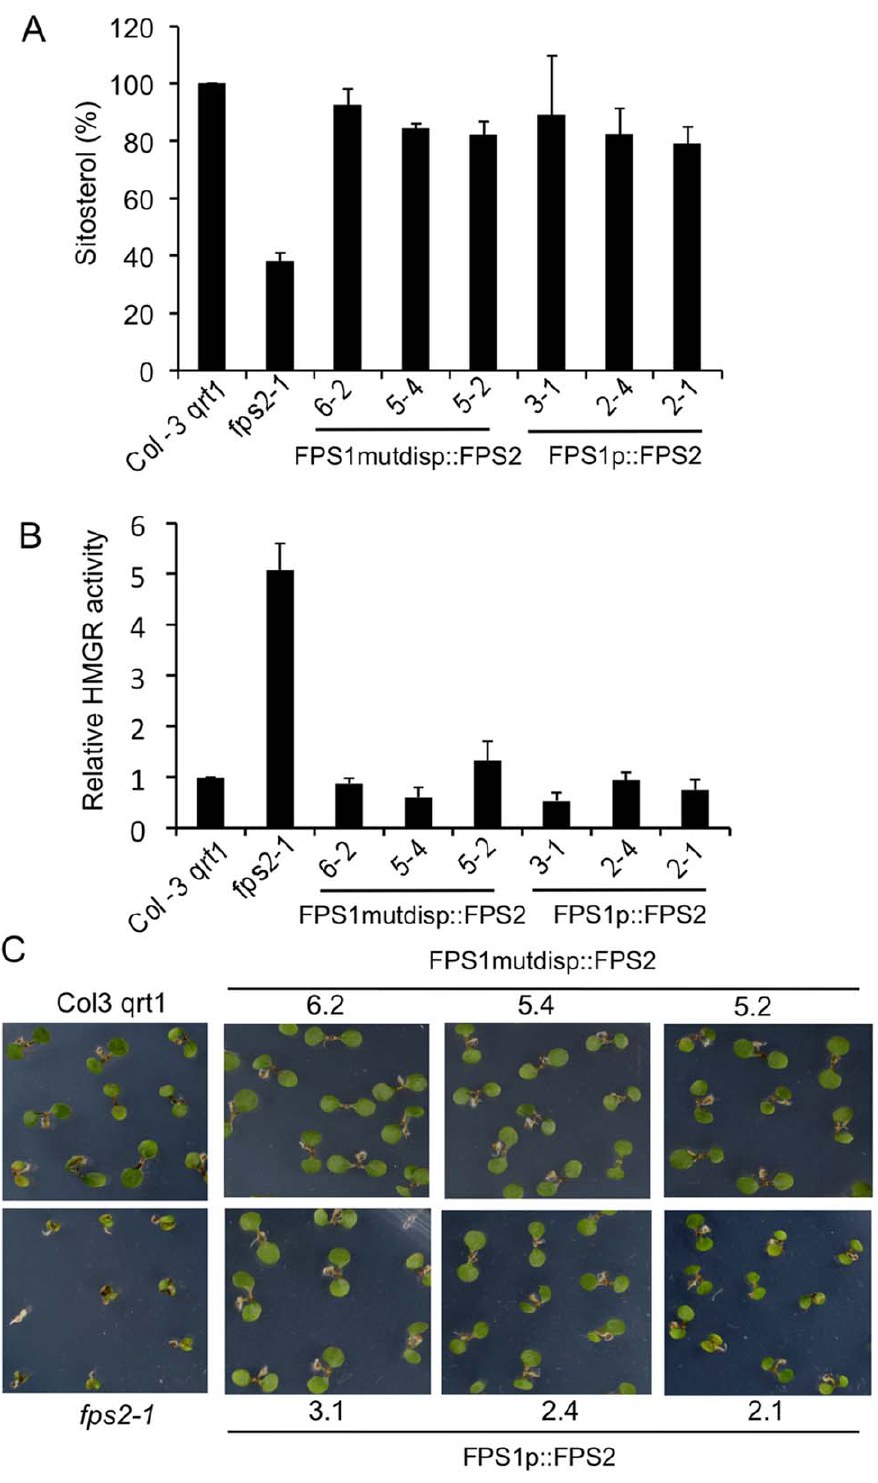
Figure 11. Reversion of fps2-1 phenotypes by expressing FPS2 under the control of the FPS1 promoter. Sitosterol (A) and HMGR activity (B) levels in seeds from Arabidopsis wild-type, fps2-1 and the indicated lines of the fps2-1 mutant harbouring FPS1mutdisp::FPS2 and FPS1p::FPS2 chimeric genes. Values are expressed relative to the wild-type values. Data represent the mean values and SE of three independent experiments. (C) Reversion of mevastatin hypersensitivity. Representative seedlings of the same lines were grown for 12 days under long-day conditions (16 h light/ 8 h dark) on MS plates supplemented with 1 m M mevastatin.